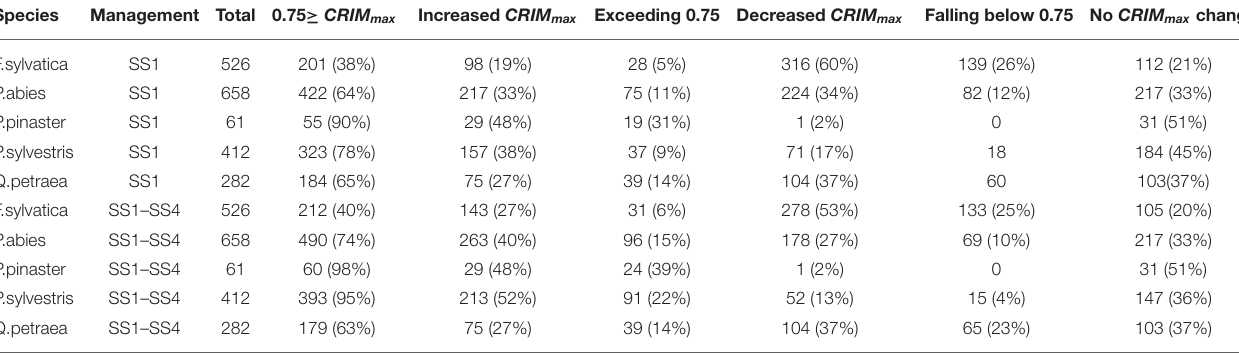
TABLE 2 | Variation of GCU extirpation threat between species under HadGEM RCP 8.5 future climatic scenario.